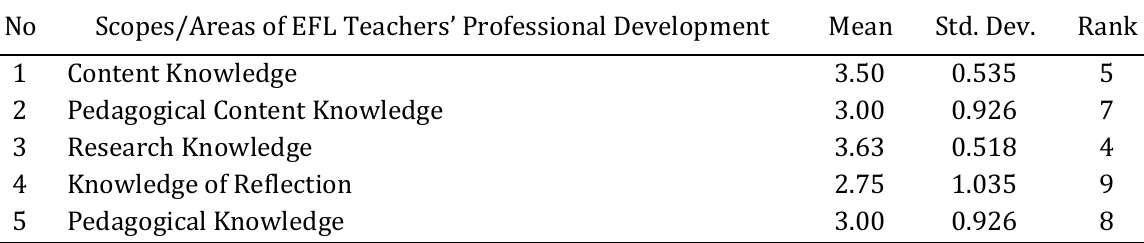
Table 3. Test Result of EFL Teachers on EFL Teachers’ Professional Development Scopes/Areas